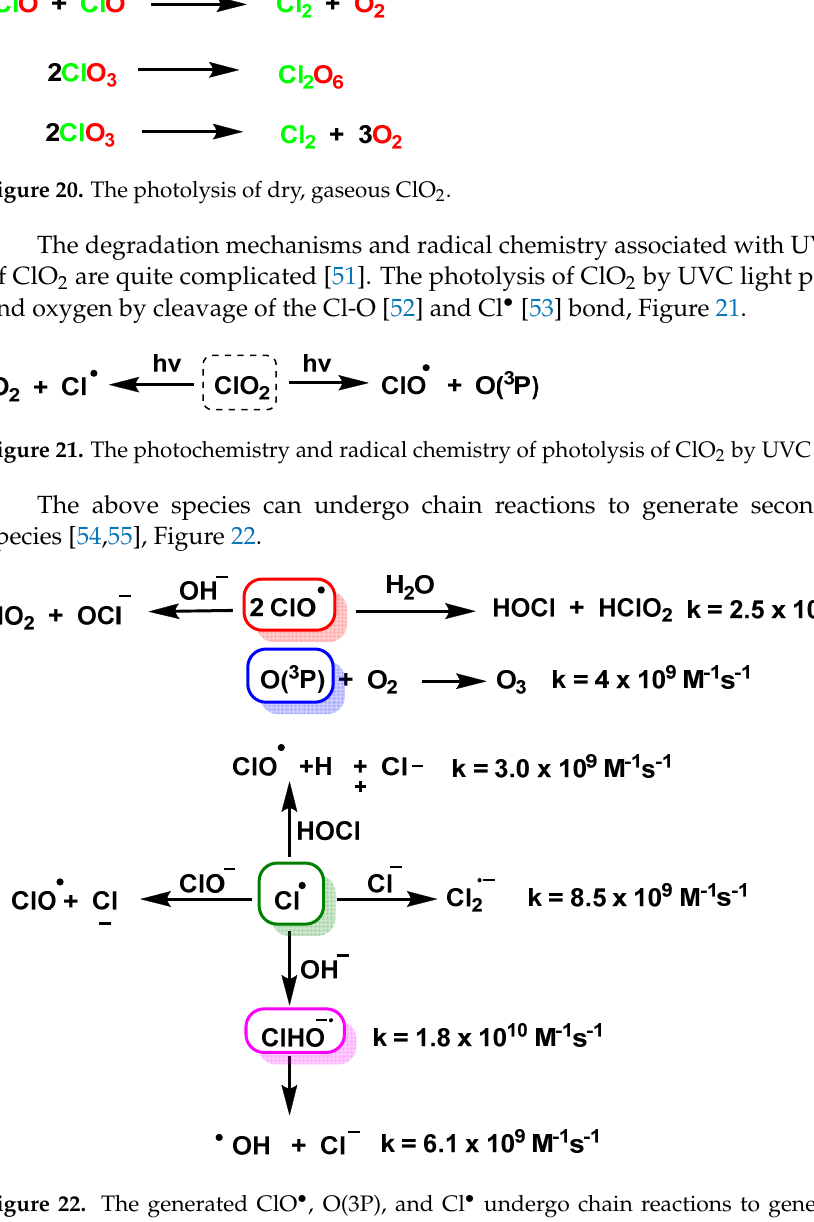
Figure 20. The photolysis of dry, gaseous ClO 2 .